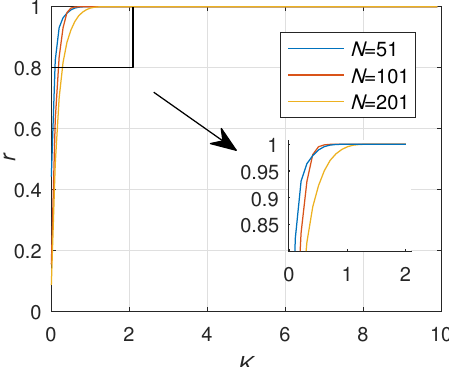
Figure 20. The stability of the weighted directed network when N is 51,101,201 ( β =